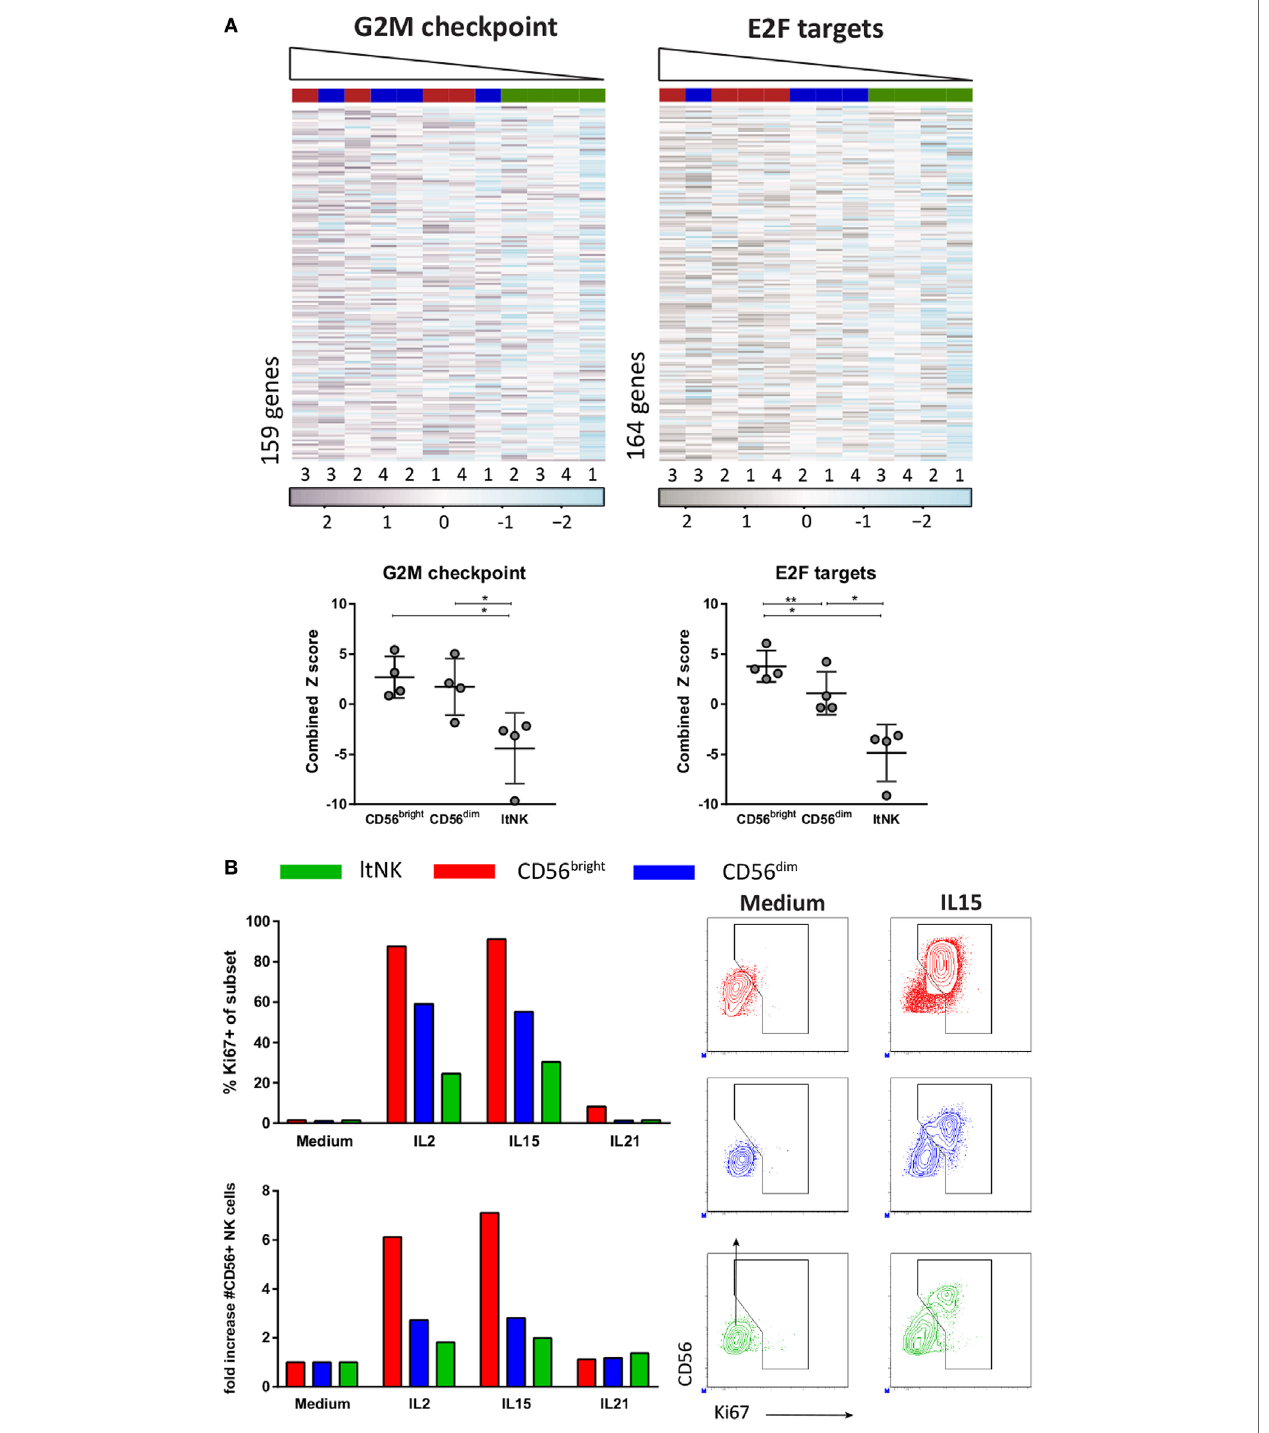
FigUre 6 | Proliferative capacity of ltNK cells is lower compared with CD56 bright and CD56 dim natural killer (NK) cells. (a) Gene set enrichment analysis using CAMERA and the Broad institute gene collections revealed that many cell-cycle related genes are downregulated by ltNK cells. Heatmaps show the normalized expression values of the hallmark gene sets G2M checkpoint (M5901) and E2F targets (M5925). The column order is based on the combined Z score of each donor NK cell population (high → low). The combined Z score is a quantification of the overall expression level of the genes per donor derived NK cell population. * P < 0.05, ** P < 0.01, by one-way ANOVA. Shown is mean ± SD. (B) Proliferative capacity was assessed by stimulating sorted bone marrow-derived NK cell populations for 6 days with IL2, IL15, or IL21. Intracellular Ki67 expression was measured by flow cytometry. The number of CD56 + NK cells is based on flow cytometer counts. Shown are dot plots of medium control and IL15 stimulated NK cell